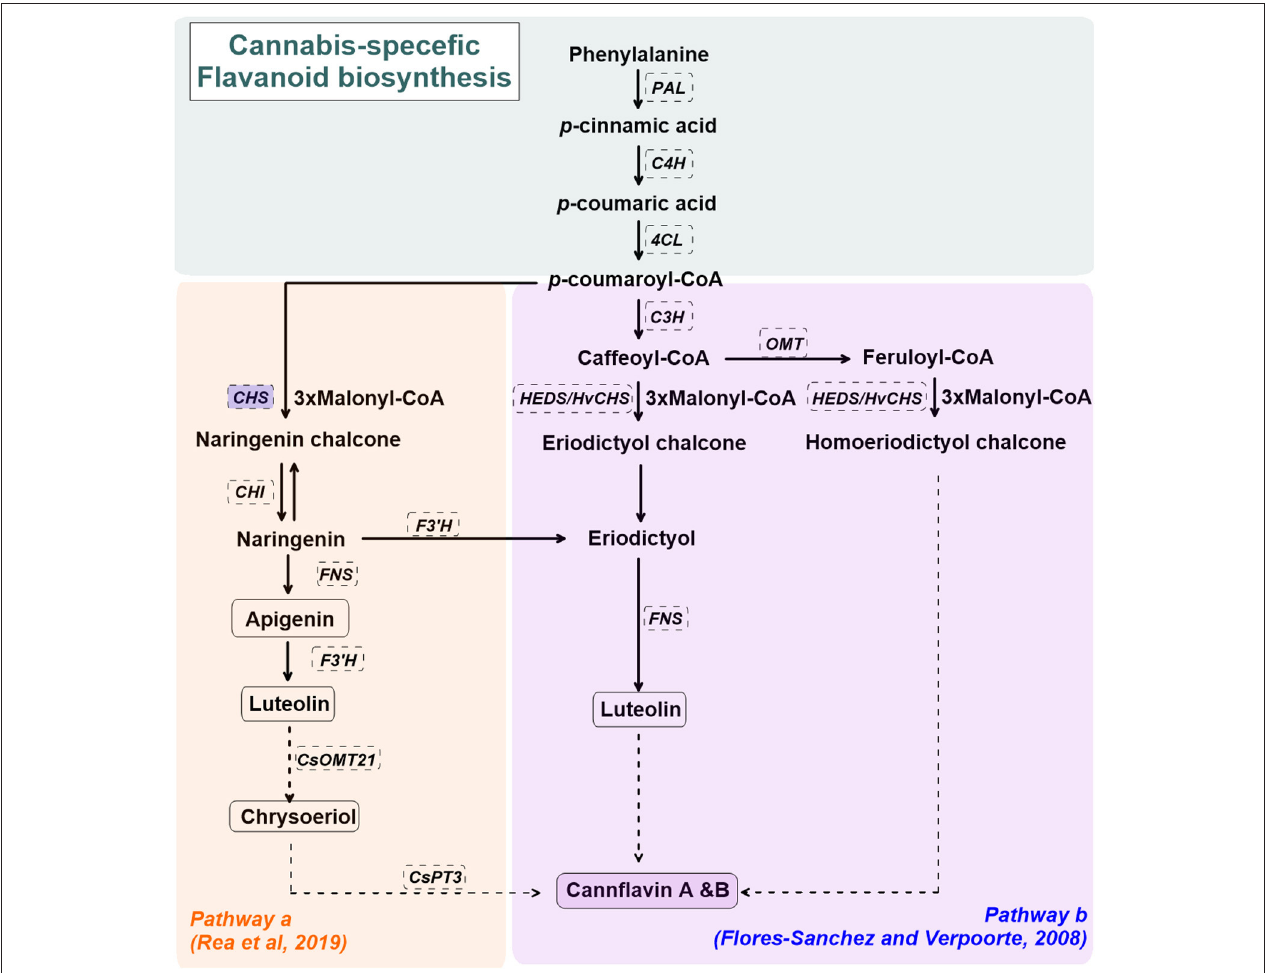
FIGURE 2 | A simplified overview of the cannabis flavonoids, cannflavin A&B, pathway(s) in cannabis ( Cannabis sativa L.), derived from Flores-Sanchez and Verpoorte (2008b) and Rea et al. (2019). Enzymes are in dashed line box. Enzymes in shaded blue boxes are upregulated by UV radiation in Arabidopsis thaliana. Dashed arrows represent proposed enzymatic reactions. CHS, chalcone synthase; CHI, chalcone isomerase; CsOMT21, C. sativa L. O-methyltransferase 21; CsPT3, C. sativa L. prenyltransferase 3; C4H, cinnamate 4-hydroxylase; C3H, p-coumaroyl-CoA 3-hydroxylase; FNS, flavone synthase; F3’H, flavonoid 3’-hydrolase; HEDS or HvCHS, homoeriodictyol/eriodictyol synthase; OMT, SAM-methyltransferase; PAL, phenylalanine ammonia-lyase; 4CL, 4-Coumarate:CoA